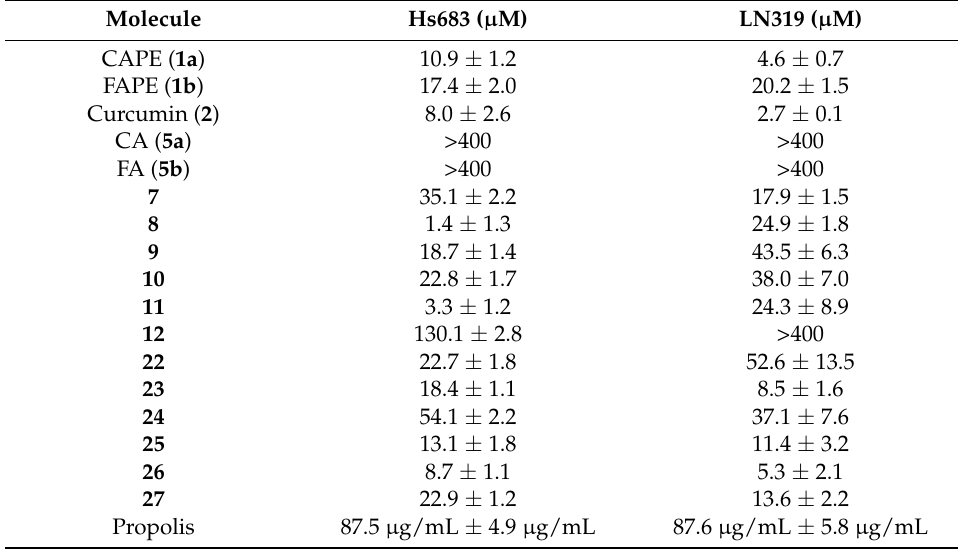
Table 2. LC 50 of molecules obtained following cytotoxic assays on Hs683 and LN319 cell lines. Data shown are means ± SEM.